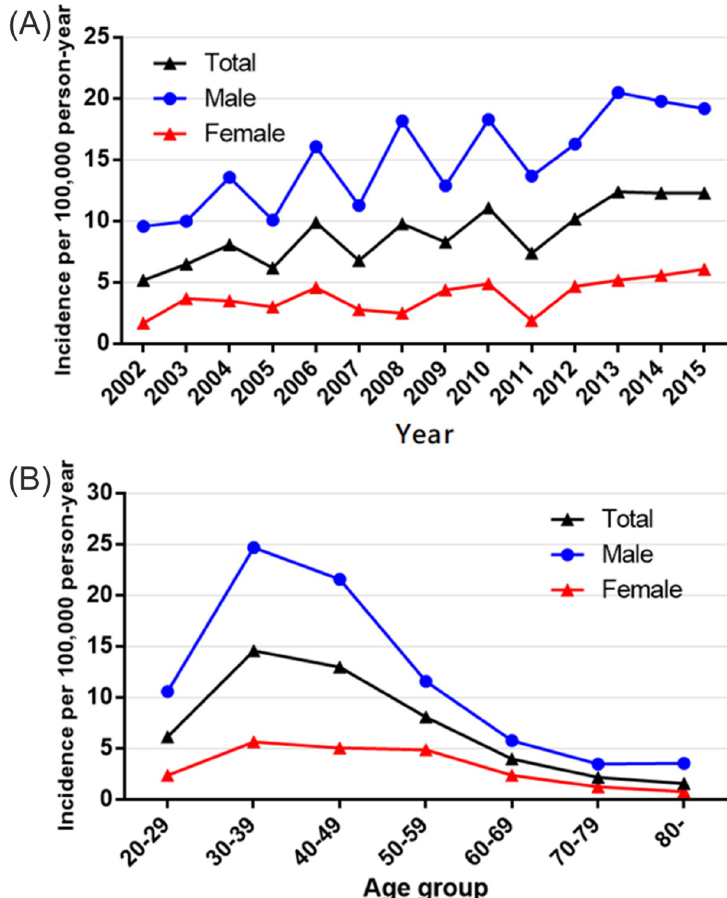
Fig 1. Incidence of achilles tendon repair (ATR) per 100,000 person-years plotted annually (2002–2015) and by age group. (A) incidence of ATR increased yearly, men surpassing women during the study period. (B) incidence of ATR peaked at 30–39 years, gradually declining thereafter.